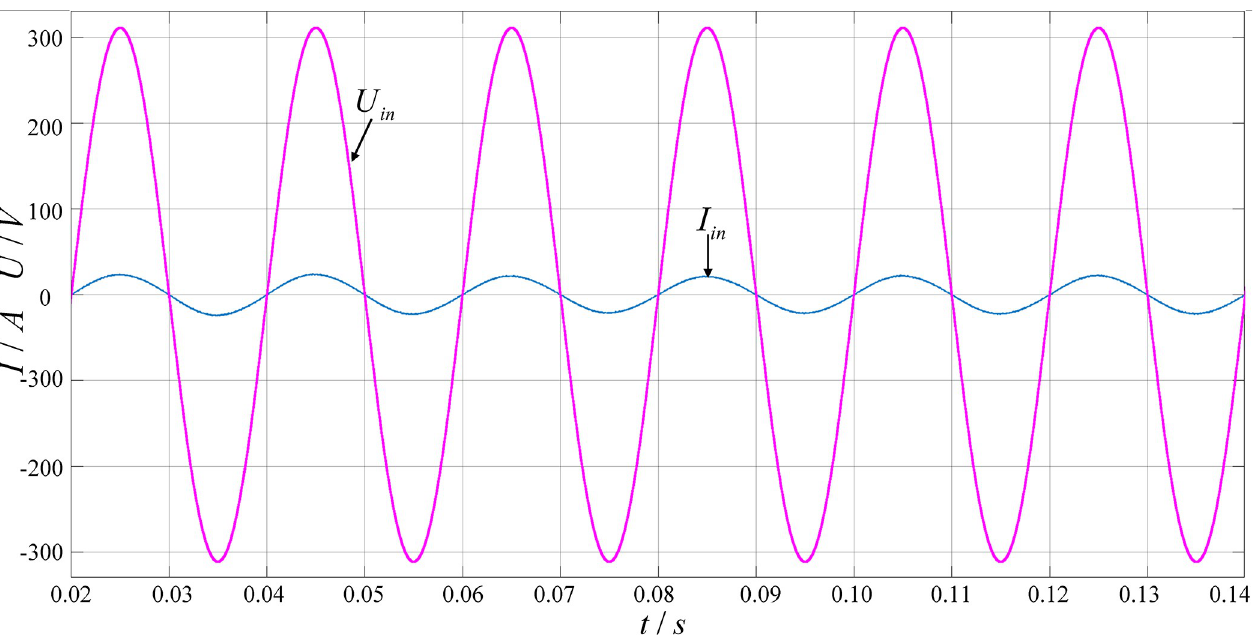
According to the system parameters and control strategy, a simulation model of a dual-output port on-board charging system is built, as shown in Fig 14.